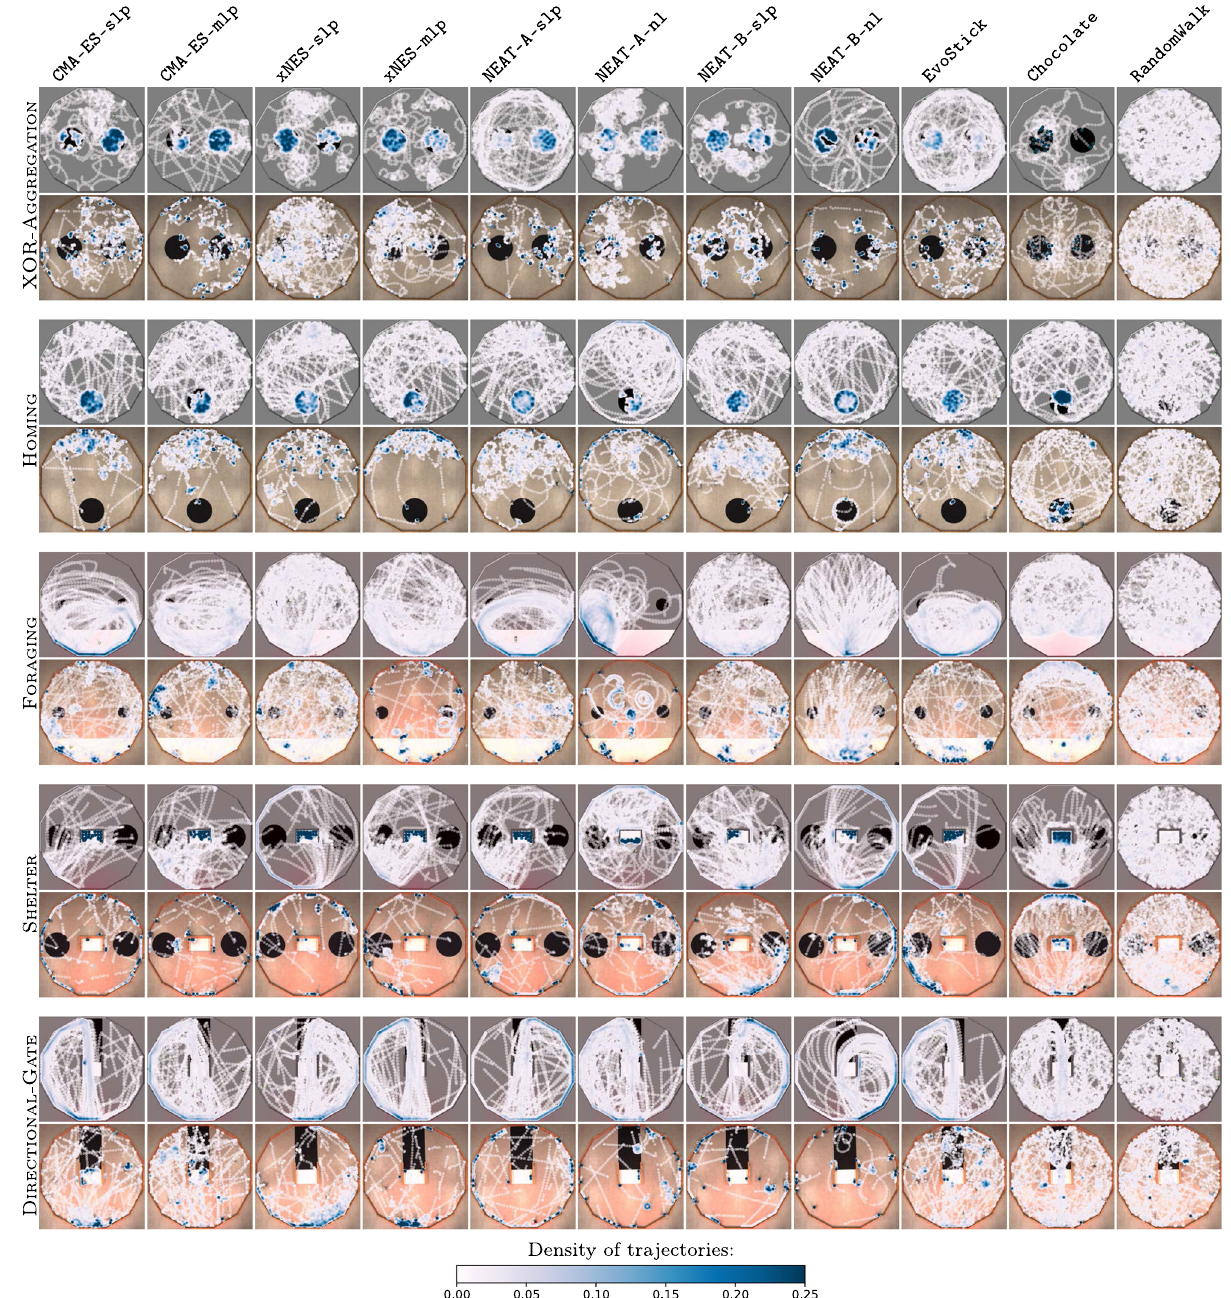
Fig. 6 Trajectories of the robots throughout the entire median runs. For each method on each mission, we report the execution in simulation (top row for each mission) and reality (bottom row for each mission) of the instance of control software that obtained a median performance in reality, out of the instances produced by that method for that mission. The color of a spot represents the amount of time a robot spent on that spot during the execution. If a robot were to stay on a spot for more than a quarter of the entire execution, the color of that spot would be dark blue (value 0.25 in the color scale). The fi gure indicates that the control software produced by the evolutionary approaches cover the space differently in simulation and reality: in reality, the robots tend to form clusters, mostly against the walls. Differences between simulation and reality are less pronounced for Chocolate and barely noticeable for RandomWalk . For each mission and each method, a direct comparison of the behavior in simulation and reality is available in Supplementary Movie